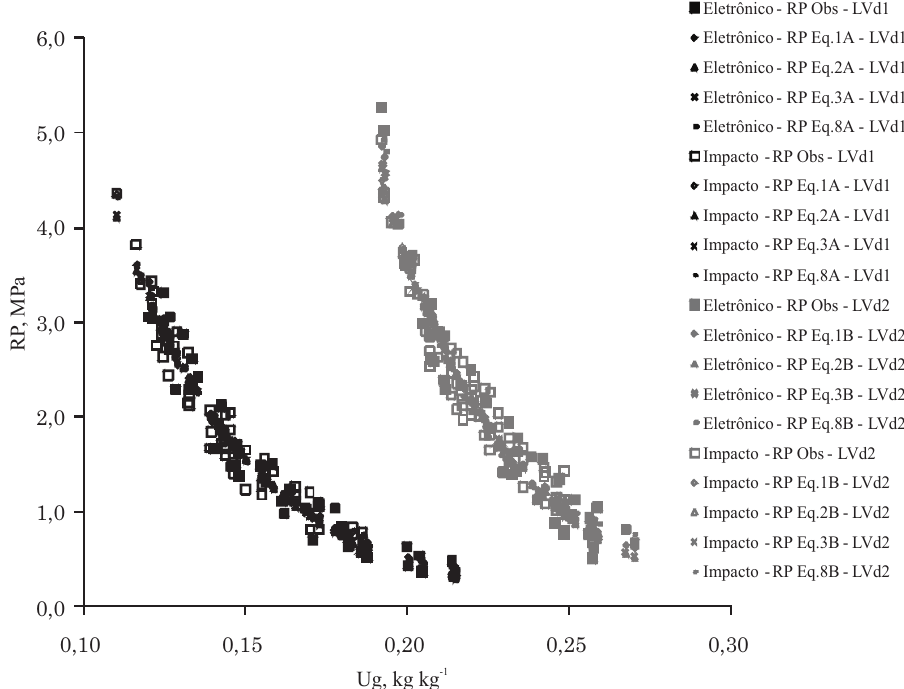
Figura 1. Valores observados (RP Obs) e estimados pelas equações 1 (RP Eq.1A e RP Eq.1B), 2 (RP Eq.2A e RP Eq.2B), 3 (RP Eq.3A e RP Eq.3B) e 8 (RP Eq.8A e RP Eq.8B) da resistência do solo à penetração